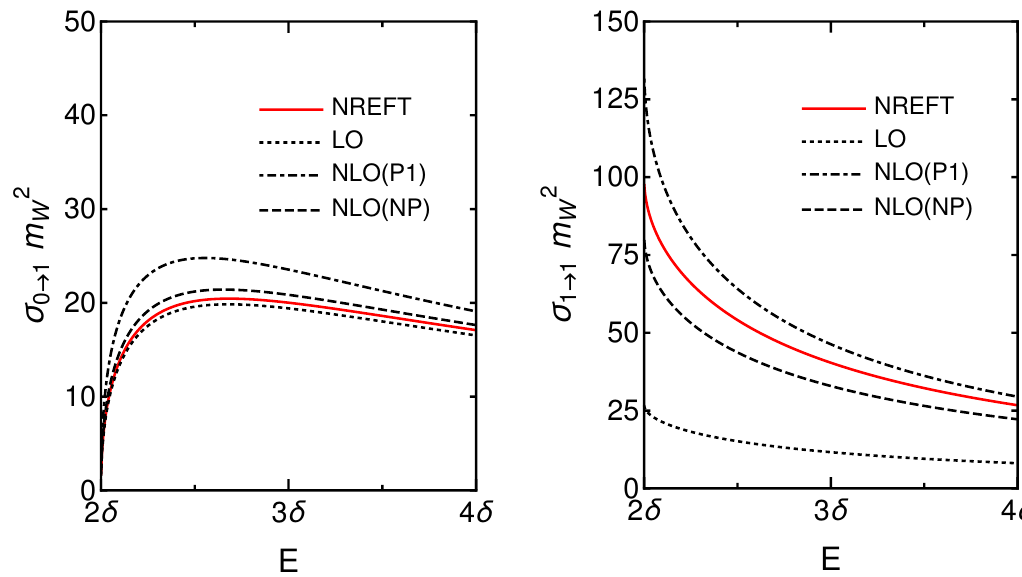
Figure 17 . The neutral-to-charged transition cross section (cid:27) 0 ! 1 (left panel) and the charged-wino elastic cross section (cid:27) 1 ! 1 (right panel) as functions of the energy E . The cross sections at the unitarity mass M (cid:3) = 2 : 88 TeV for (cid:14) = 170 MeV and (cid:11) = 0 are shown for NREFT (solid curve) and for ZREFT at LO (dotted curve), NLO(P1) (dot-dashed curve), and NLO(NP) (dashed curve). In (cid:12)gure 17, the NLO(NP) and NLO(P1) predictions for the neutral-to-charged